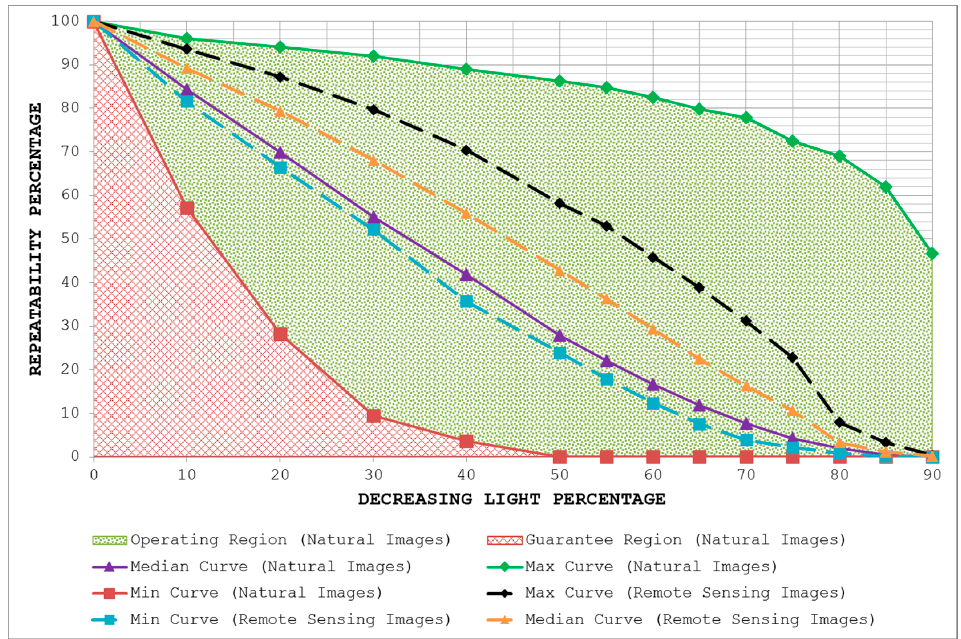
Figure 24. Results of MSER for remote sensing images under decreasing light. The two graphs (natural images and remote sensing images) are overlaid to produce one plot for MSER. Note that although the operating and guarantee regions are defined using the presented database of natural images [50], the curves (median, max and min) in the case of remote sensing images still lie inside the defined operating region and do not cross over to the guarantee region.